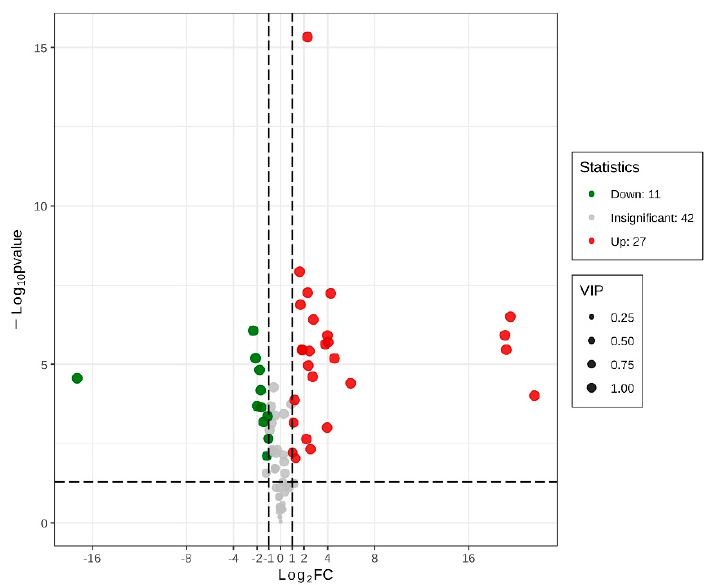
Figure 2. VIP (variable importance for projection) plot of differential metabolites in TH vs. TL blooming flowers. Red dots were metabolites accumulated more in TH, and green dots were metabolites accumulated more in TL.